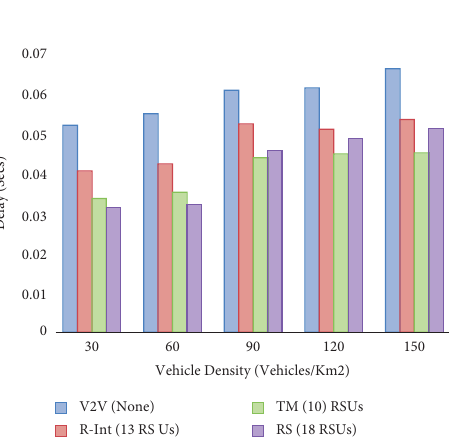
Figure 23: Jitter (ns).